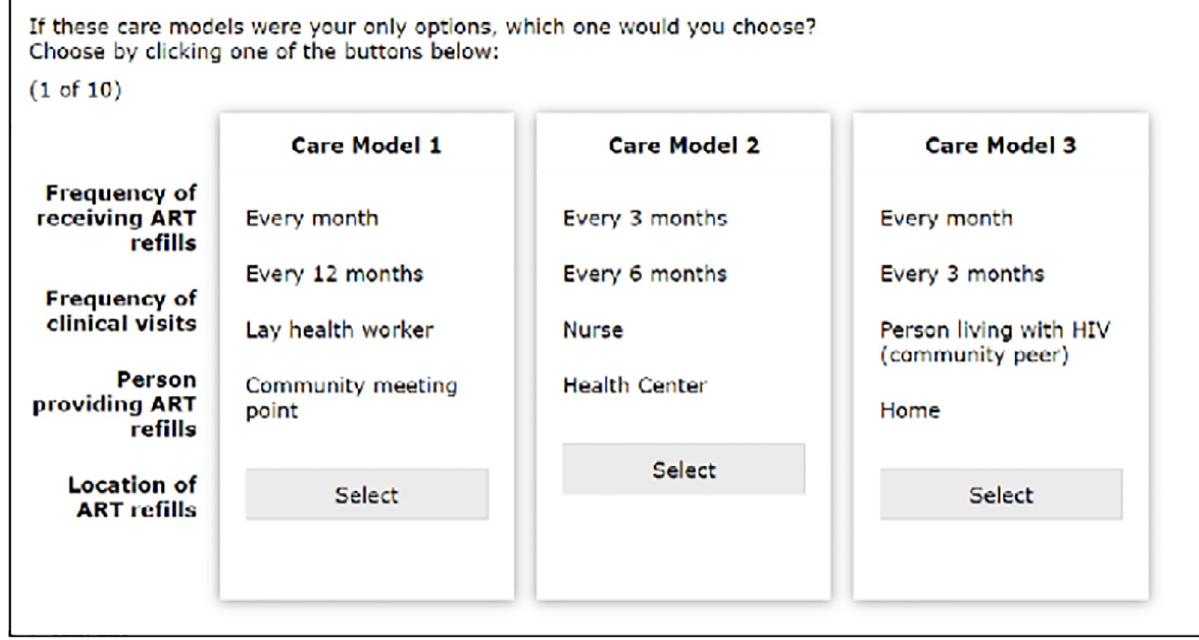
Fig 1. Sample care models in the